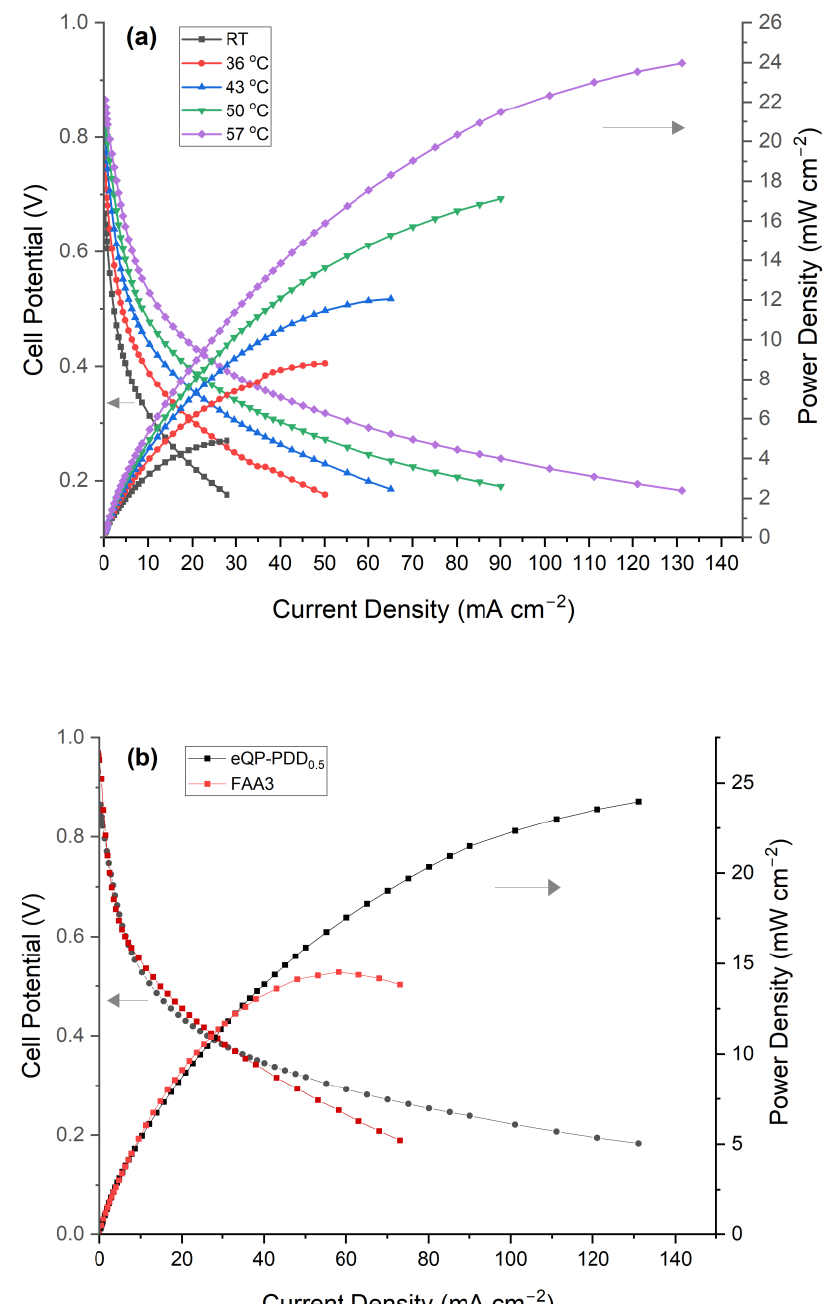
Figure 12. Power density and polarization curves of eQP-PDD 0.5 AEMs. ( a ) Different temperature, ( b ) comparison with FAA-3-50 at 57 ◦